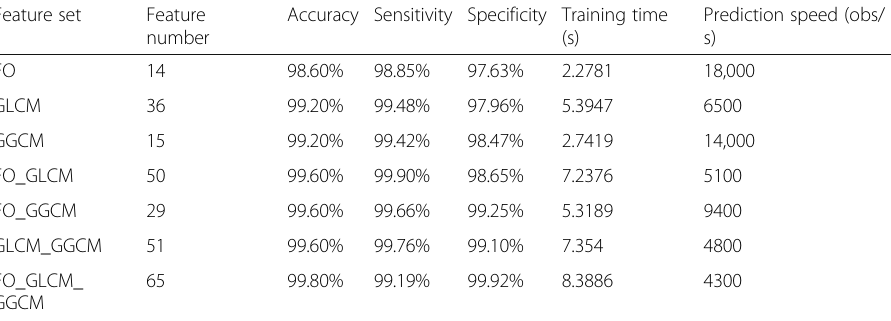
Table 2 The performances of KNN classifiers based on different kind of features Feature